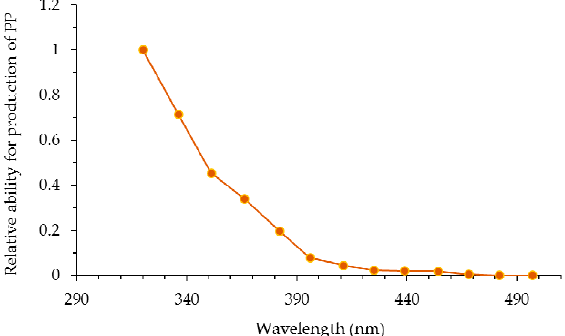
Figure 3. Relative effect-wavelength curve of persistent pigmentation (PP).